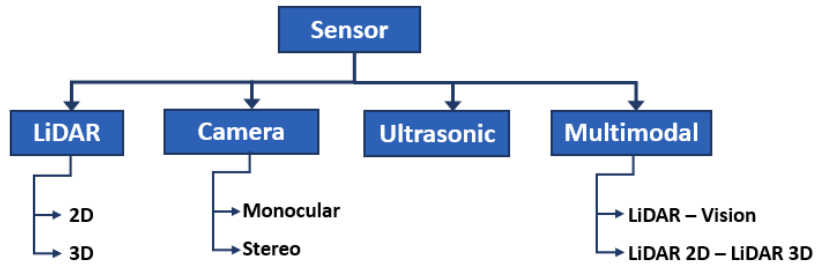
Figure 5. Types of sensors for data